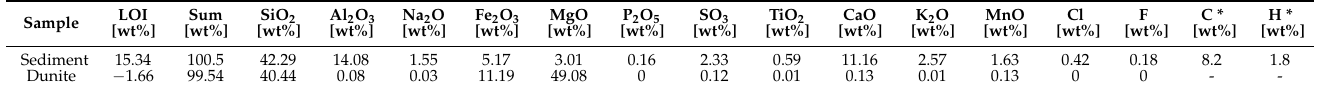
Figure A3. Close-up of reaction zone. Orthopyroxene inclusions within clinopyroxene (indicated by blue arrows) reveal growth of the metasome layer at the expense of dunite. (Phases: Ol—olivine, Opx—Orthopyroxene, Cpx—Clinopyroxene, Mgs—Magnesite, Phl—phlogopite). Table A2. Major element compositions of starting materials.